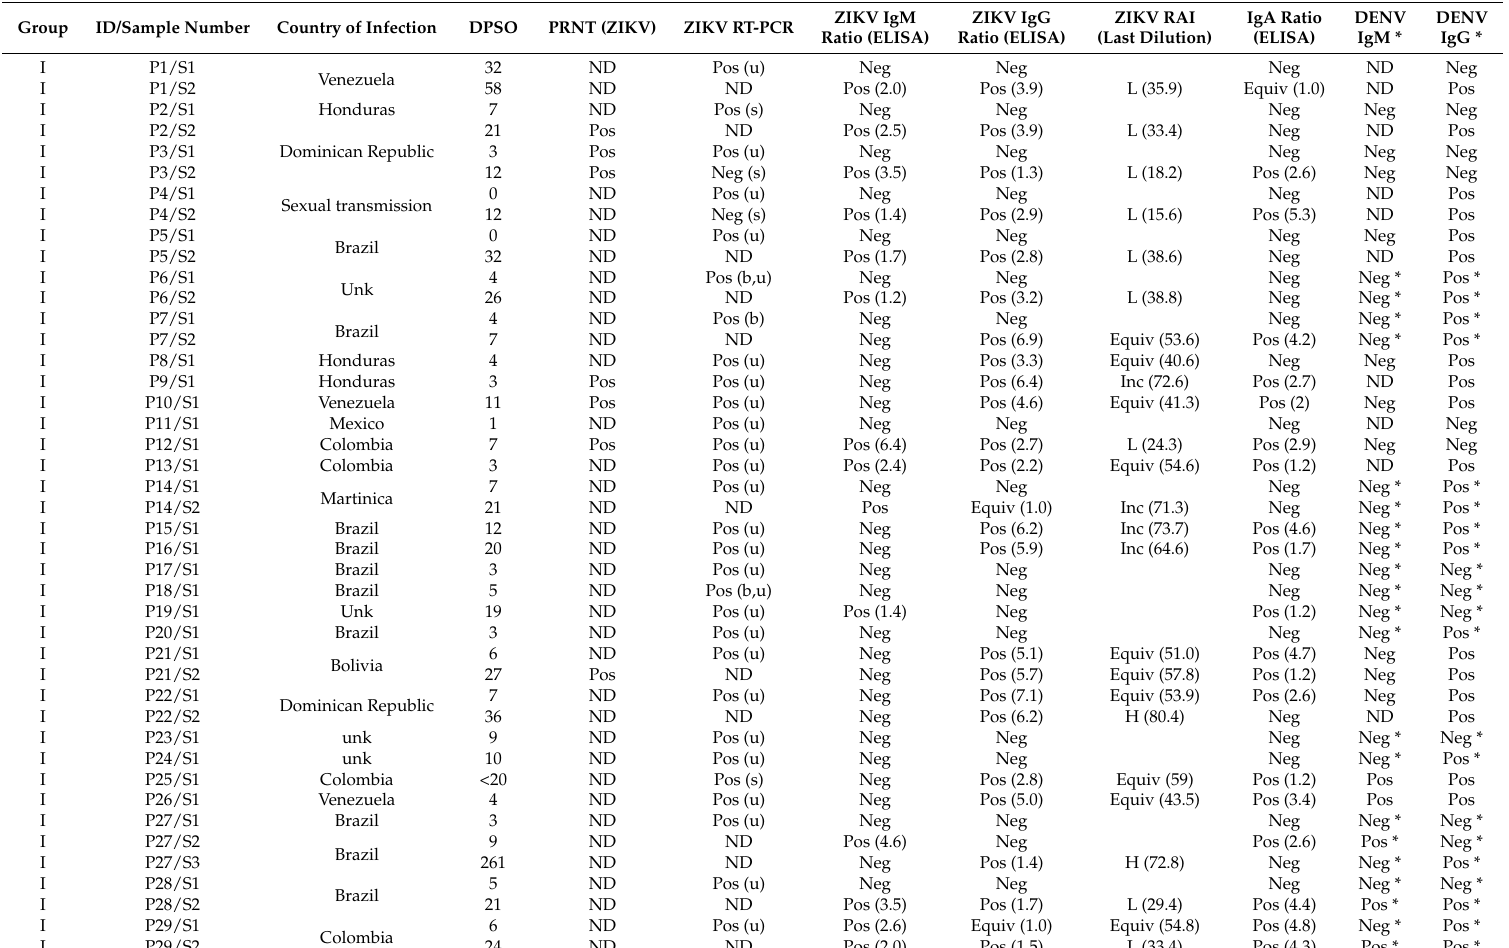
Table 1. Group I-PCR and serological results for patients with ZIKV